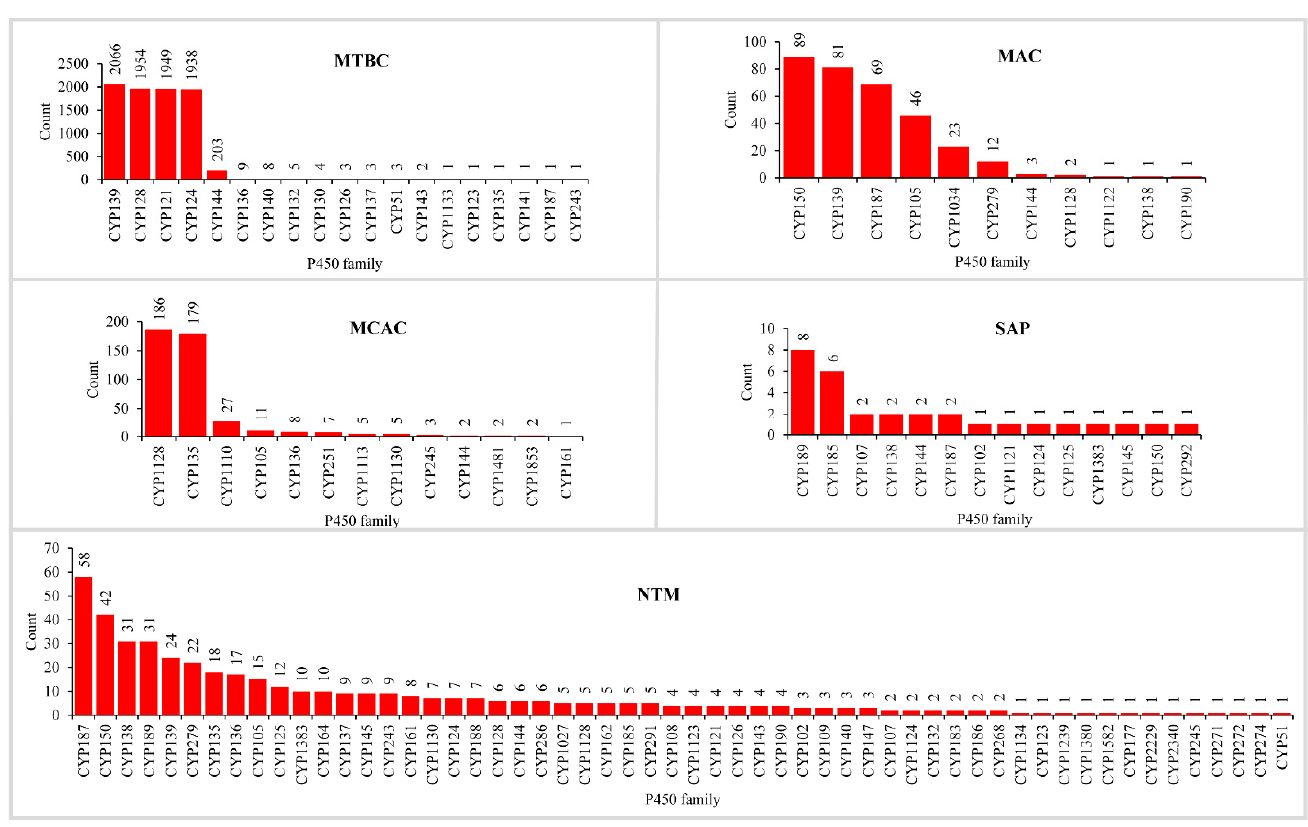
Figure 4. Comparative analysis of P450s that are part of biosynthetic gene clusters (BGCs) in mycobacterial categories. Detailed information on the P450s part of BGCs, their species names, and BGC types are presented in Table S6. A P450 family analysis in individual categories is presented in Table S7. Abbreviations: MTBC, Mycobacterium tuberculosis complex; MCAC, M. chelonae-abscessus complex; MAC, M. avium complex; MCL, Mycobacteria causing leprosy; NTM,